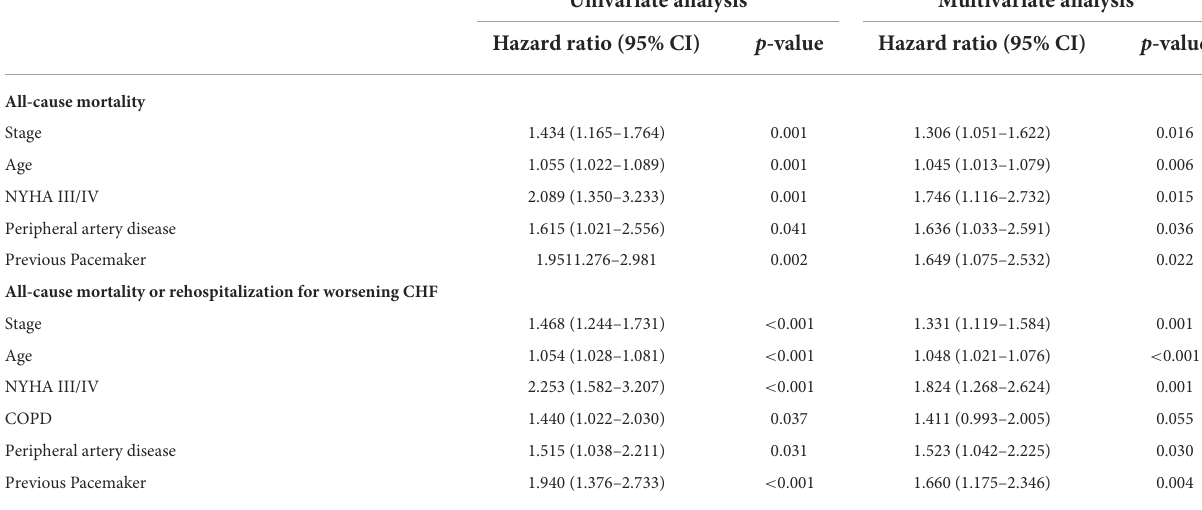
TABLE 4 Univariate and multivariate Cox proportional hazard analysis for variables yielding p < 0.05 for all-cause mortality and the composite of all-cause mortality or rehospitalization for worsening CHF at 2